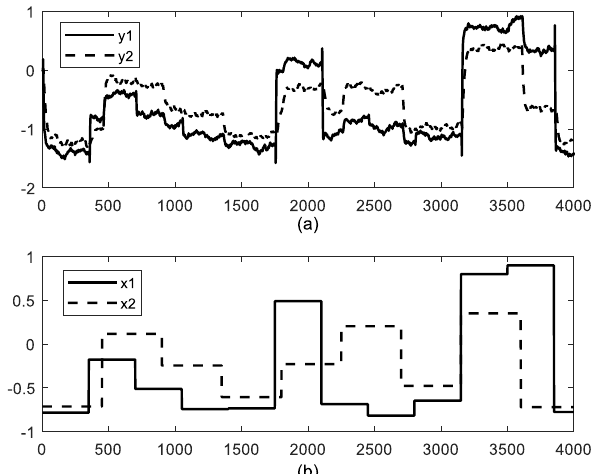
Table 1. The index ϕ for different model parameters.